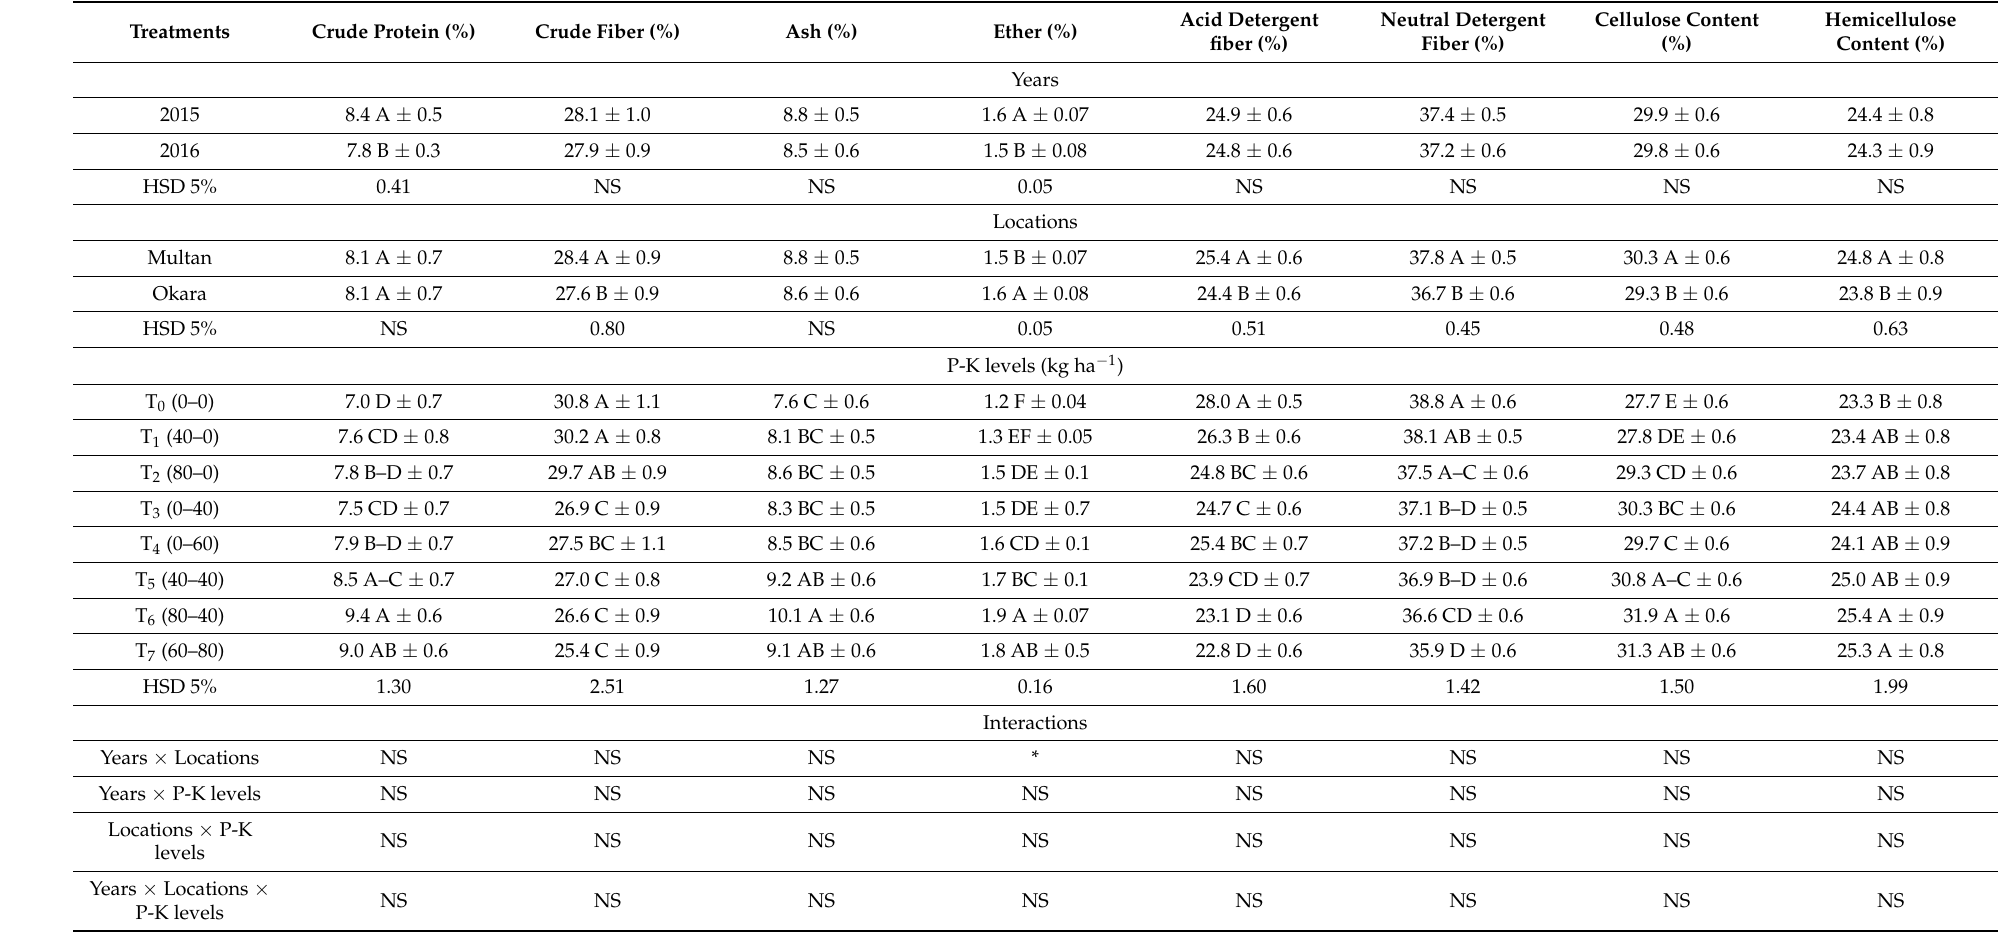
Table 6. Influence of P-K levels on sorghum quality traits during both years and